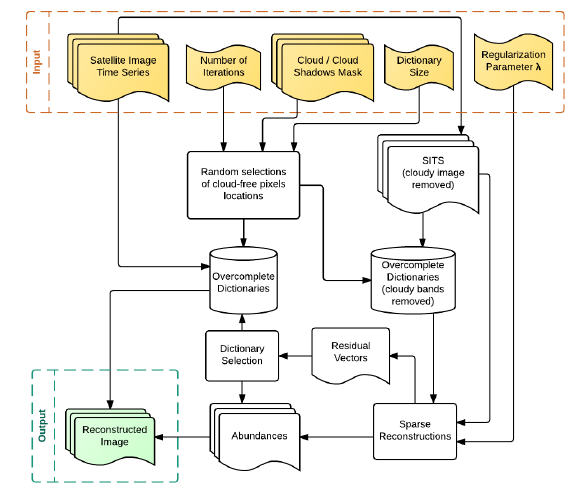
Figure 1. Workflow for the described method. In orange the re- quired input (data and parameters), in green the output. Most of the required input parameters can be empirically or adaptively derived without requiring too much